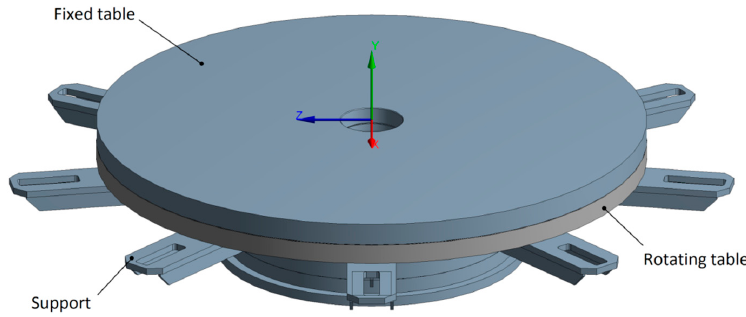
Figure 2. Fixed and rotary tables of the Transfer Machine with nine divisions.